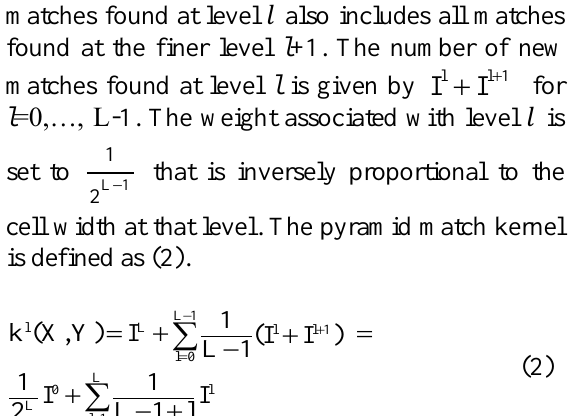
Figure 1. Example of constructing a three-level pyramid. Image has three feature types, indicated by circles, diamonds, and crosses. Each spatial histogram is weighted according to Eq.